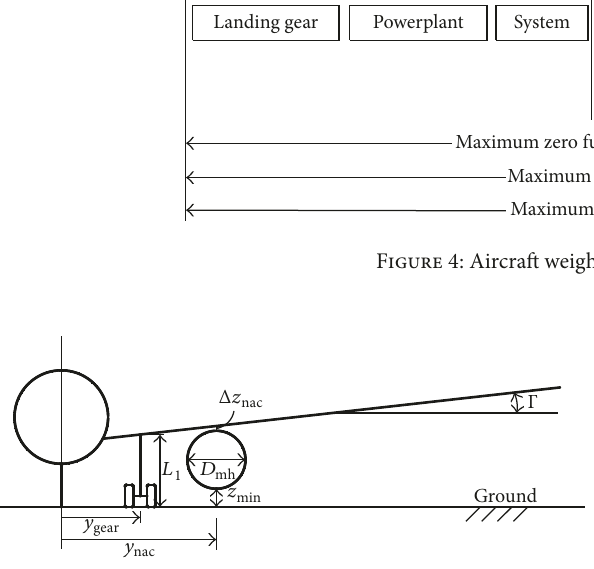
Figure 5: Nacelle ground clearance geometry.